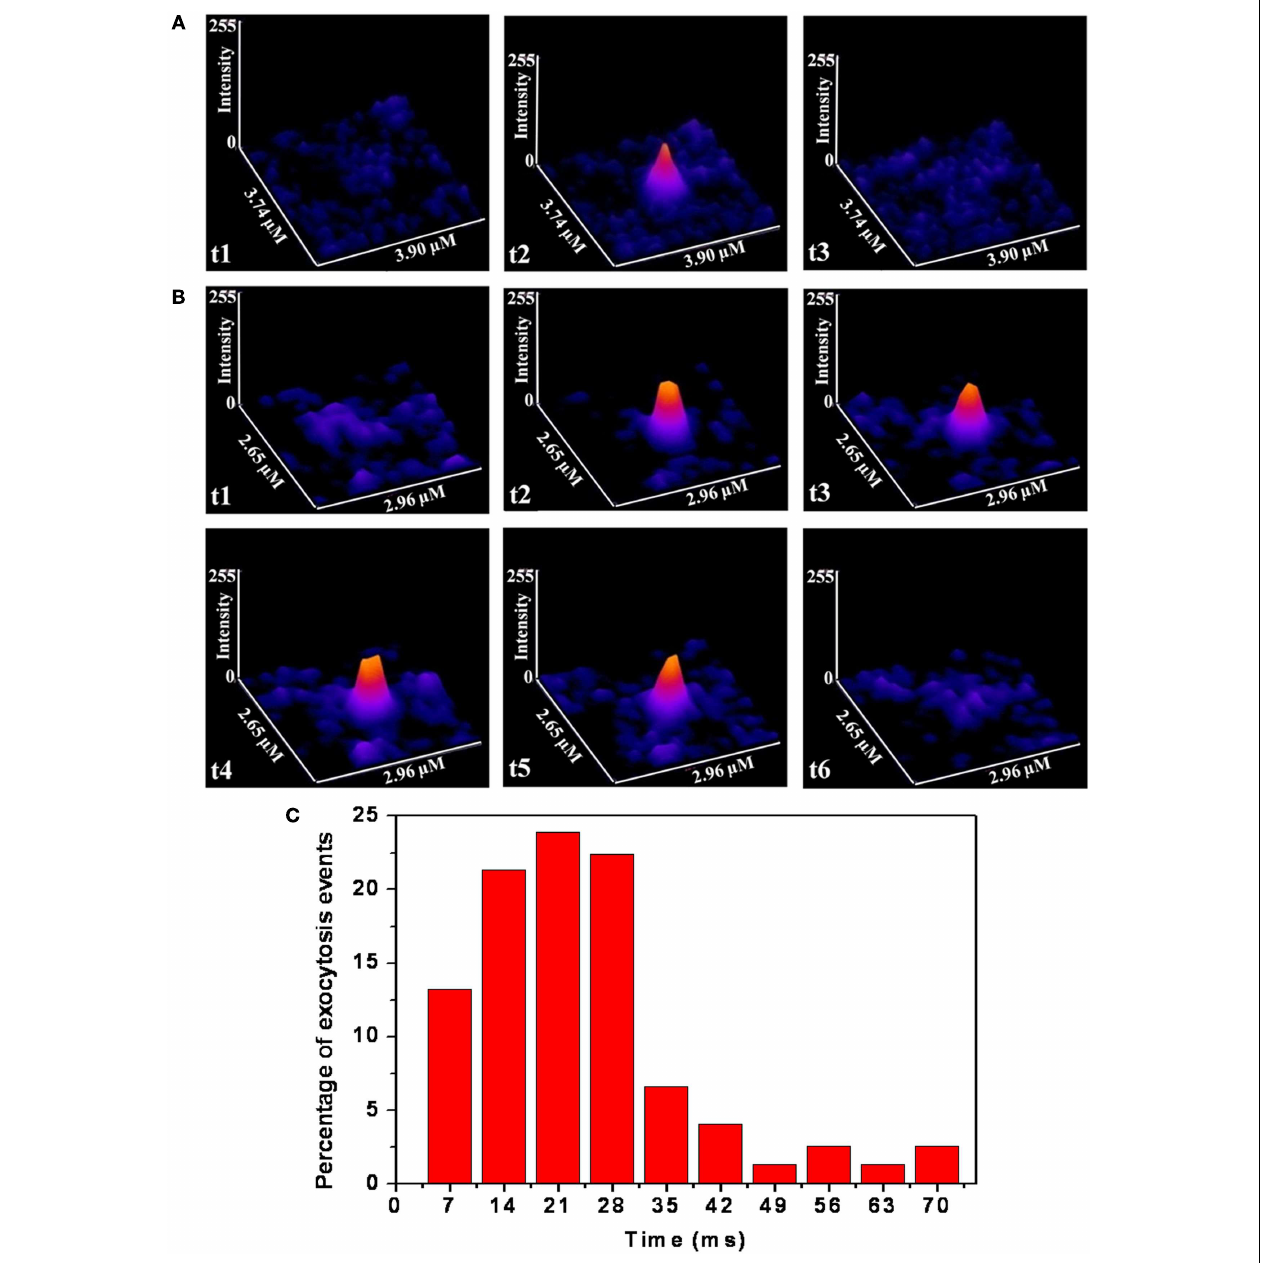
and 4 (B) frames respectively. (Image intensities are false color coded) (C) Histogram of the percentage of events vs. docking times ( N = 75 spots from three cultured serotonergic